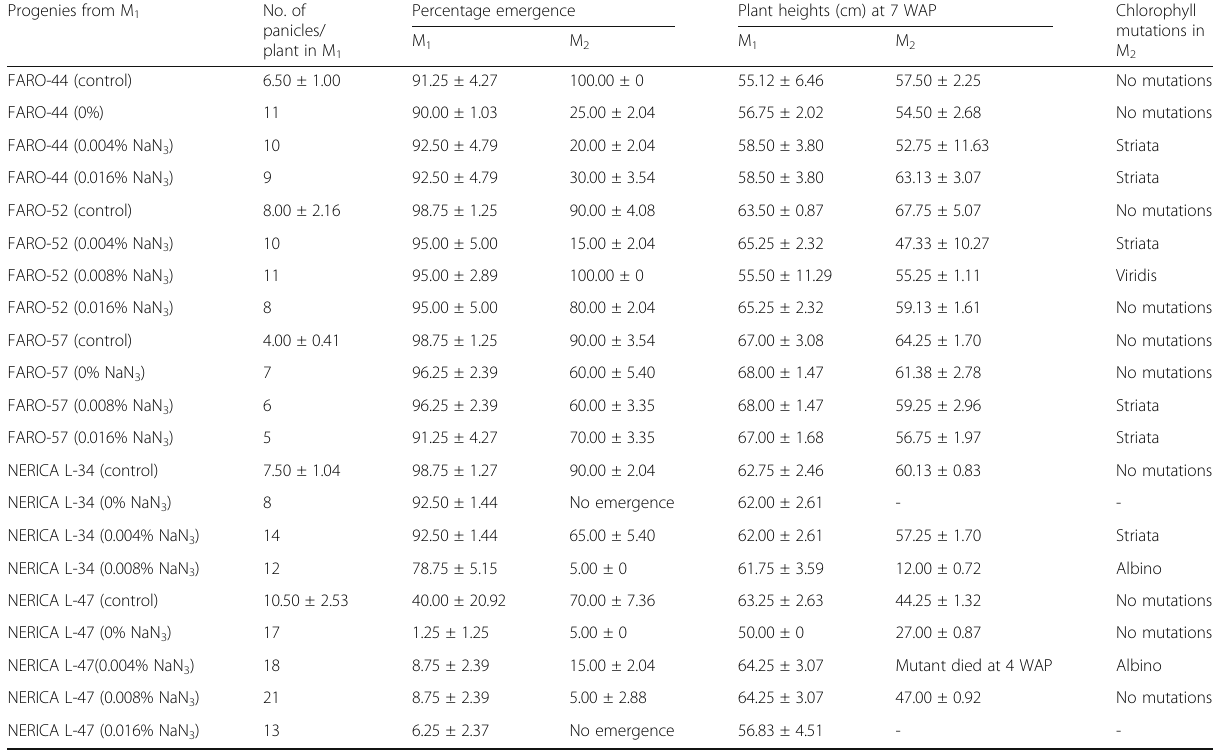
Table 9 Effect of sodium azide on some parameters of selected progenies in M 1 and M 2 generations Progenies from M 1 No. of panicles/ plant in M 1